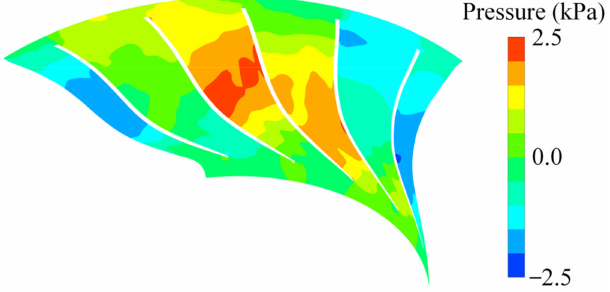
Figure 12. The pressure field for DMD mode of 23.394 Hz at 97% span of the impeller (IGV30, ϕ =